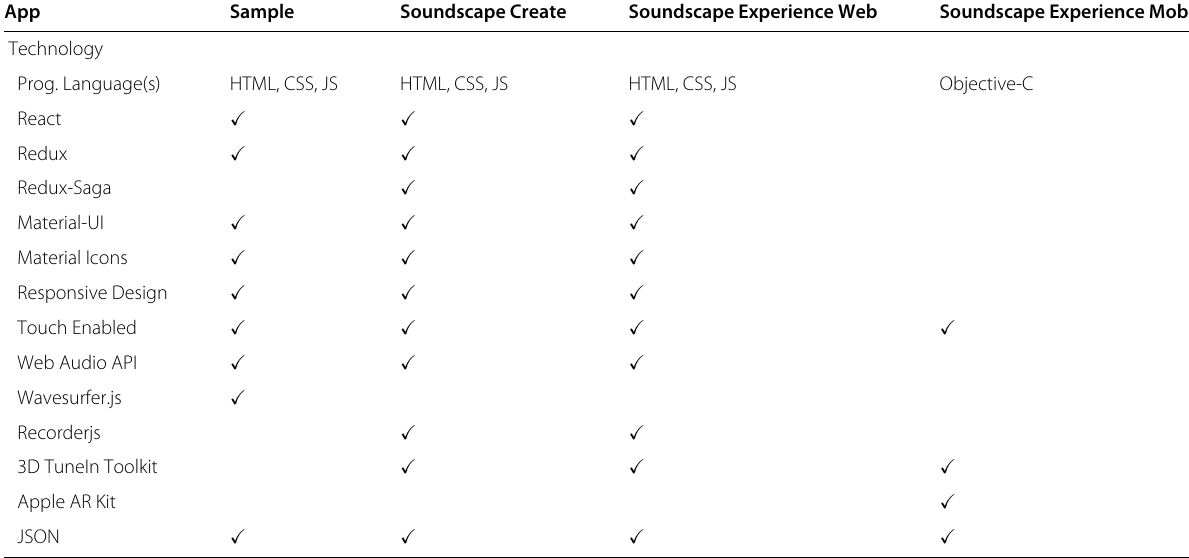
Table 1 Technologies used by PlugSonic App Sample